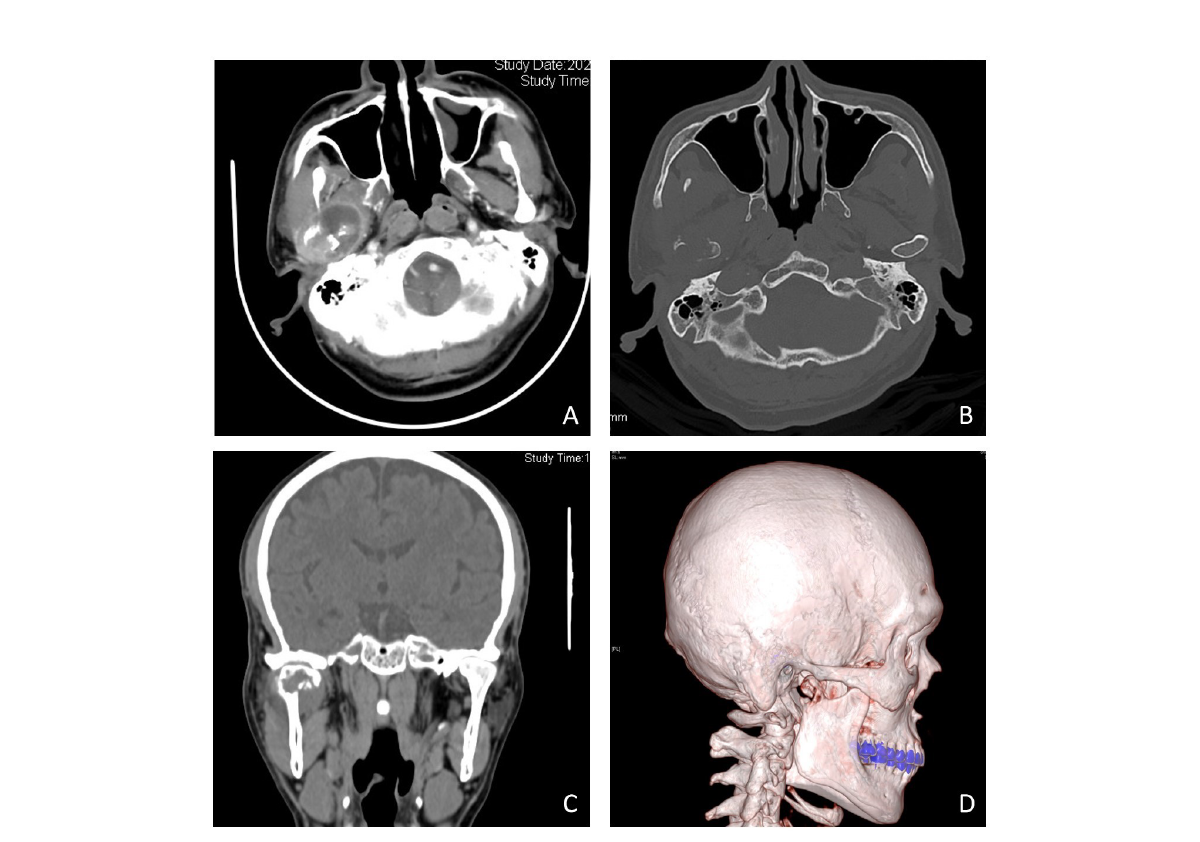
FIGURE 1 Imaging manifestations of condylar metastasis in contrast-enhanced (CT) and three-dimensional imaging. Contrast-enhanced CT shows a mass (A) , bone-window imaging indicates that the condylar bone has been destroyed (B) , and coronal position imaging and three-dimensional reconstruction imaging indicate that the condylar bone has been destroyed and fractured (C, D)